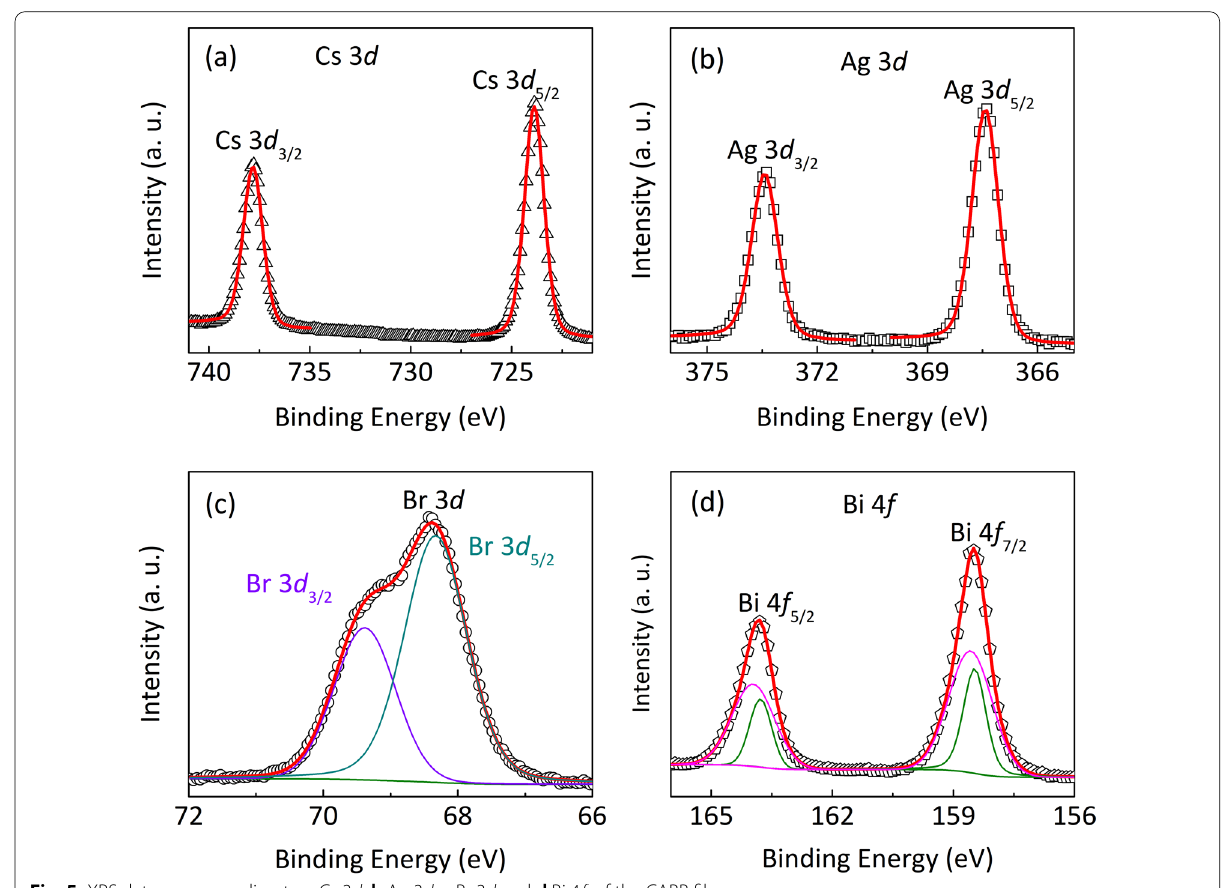
Fig. 5 XPS data corresponding to a Cs 3 d , b Ag 3 d , c Br 3 d and d Bi 4 f of the CABB